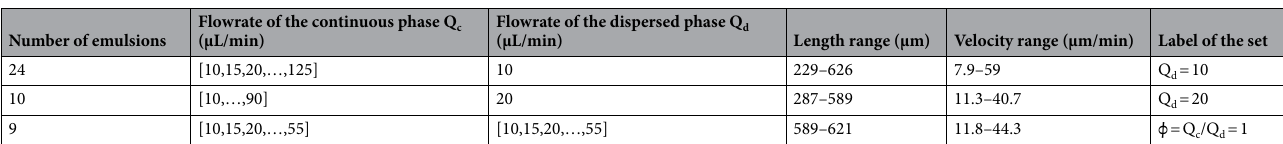
Table 1. Datasets of the emulsion. Three main datasets have been tested: two with fixed flowrates of the dispersed phase, and one with fixed ratio between the two flowrates used for the droplets production. The flowrate of the continuous phase Q c is considered as the sum of the flowrate injected in the two channels of the cross-junction.